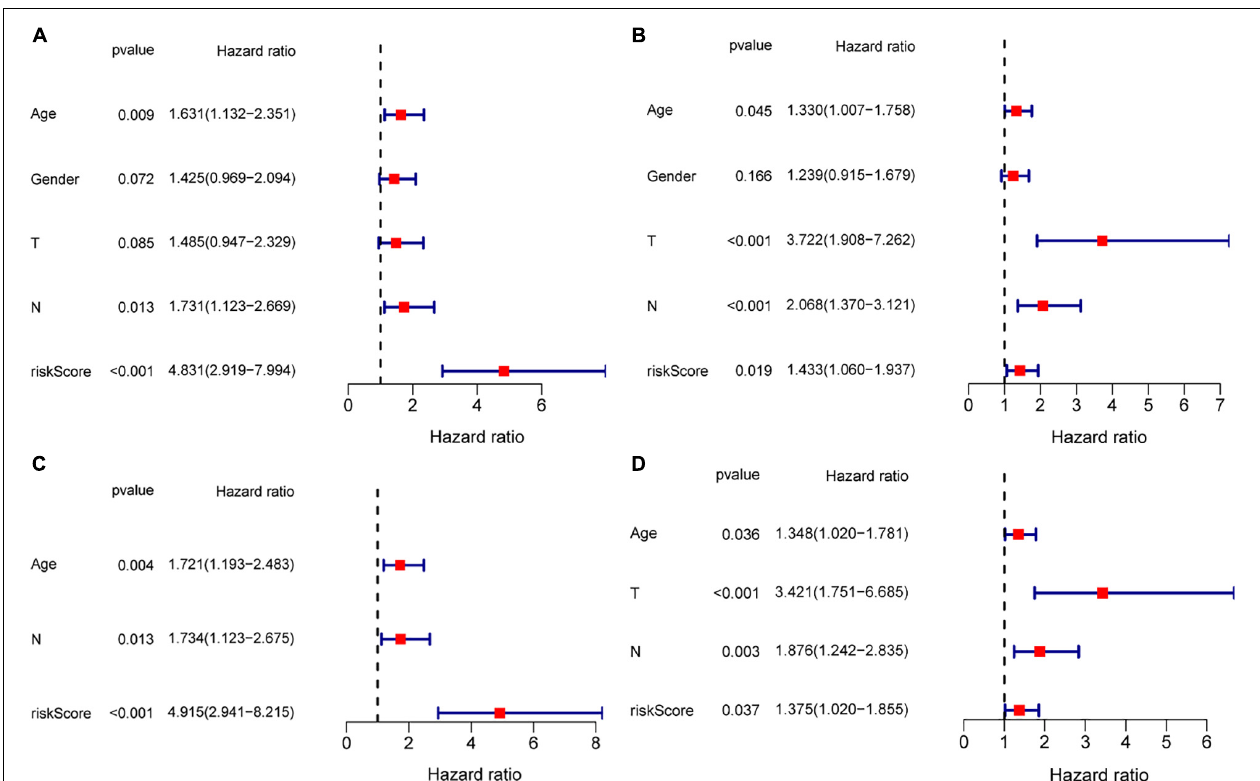
FIGURE 8 | Risk score as an independent prognostic signature for patients with GC. Results of the univariate and multivariate Cox regression analyses of OS in the TCGA cohort (A,C) and in the GEO cohort (B,D)